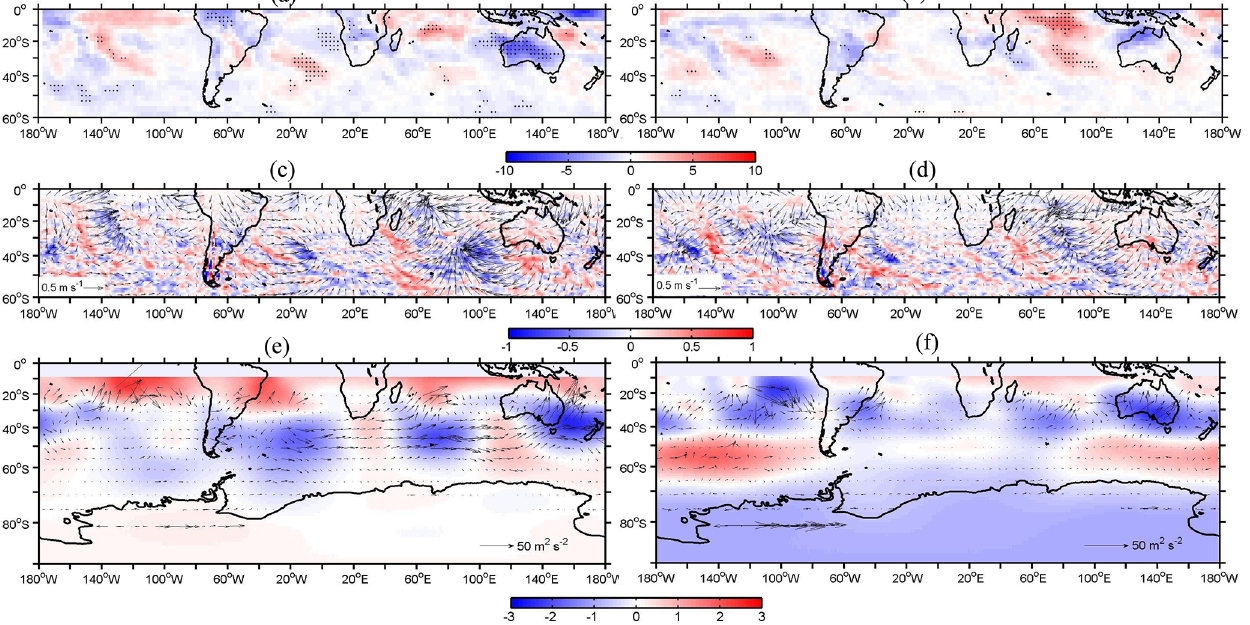
Figure 7. Regression maps of (a, b) the OLR (Wm − 2 ), (c, d) the RWS (10 − 10 s − 2 ) and the 200hPa divergent wind (vector), and (e, f) the WAF (vector) and streamfunction (m 2 s − 1 ) on the summertime SIOD index over the 1979–1999 period (a, c, e) and the 2000–2020 pe- riod (b, d, f)